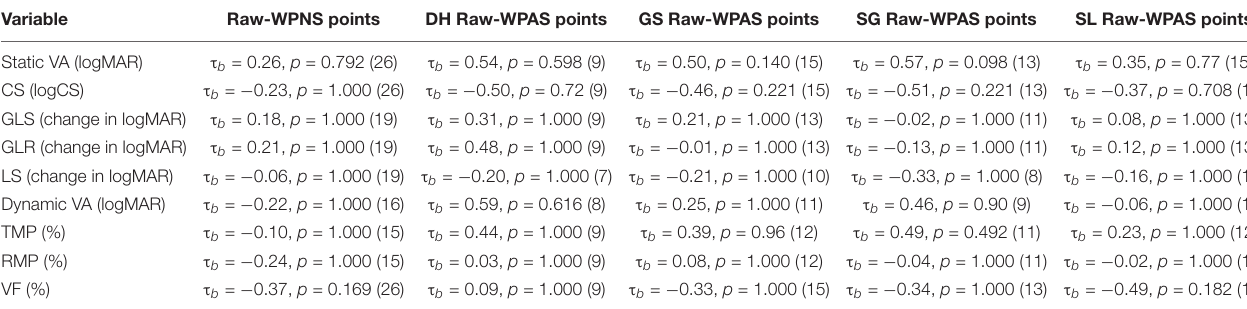
TABLE 5 | Summary of correlations of visual functions with skiing performances.